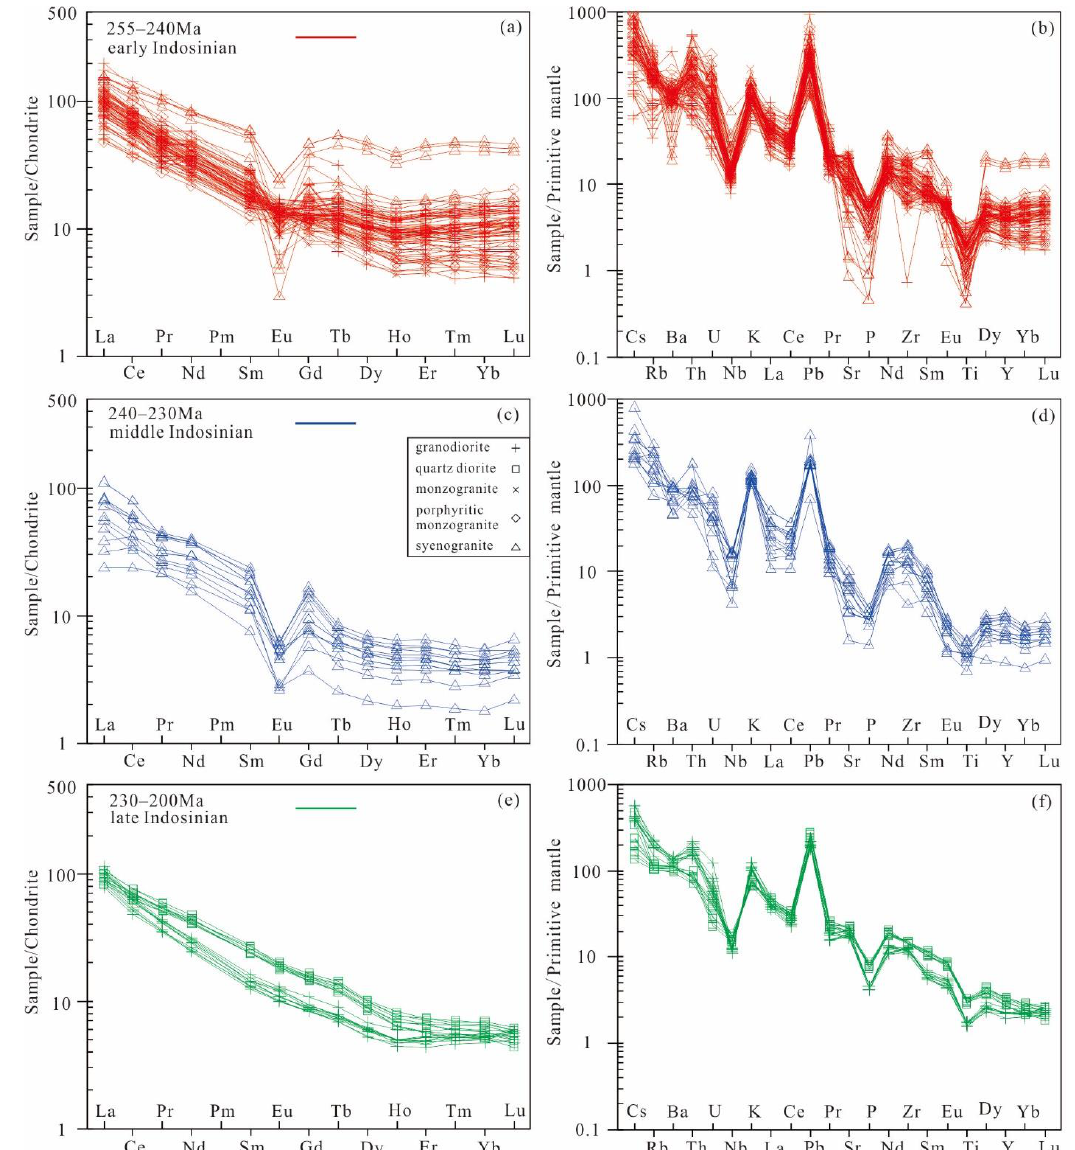
Figure 5. Chondrite-normalized REE distribution patterns ( a , c , e , normalization values after [43]); primitive mantle-normalized trace element spider diagrams ( b , d , f , normalization values after [44]) for the Indosinian granite in the eastern region of the EKO.